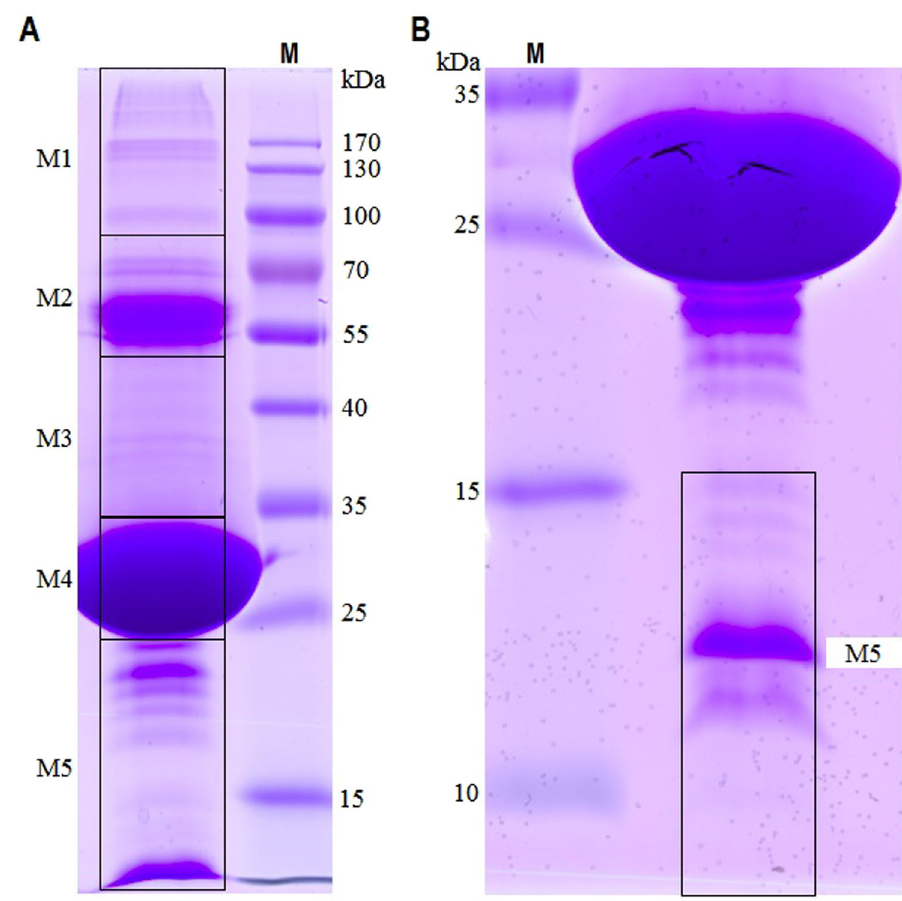
Figure 1. BmNPV polyhedra matrix proteins were separated on 12% ( A ) and 15% ( B ) SDS-PAGE gels. Purified polyhedra were treated with an alkaline solution. Undissolved polyhedra were removed by low-speed centrifugation at 500 × g. The resulting supernatant was collected and then centrifuged by continuous sucrose gradients to remove the ODVs. Protein sample over the upper gradient was separated by SDS-PAGE. Proteins on the gel were excised into five contiguous sections (M1 to M5) and subjected to in-gel digestion and LC- ESI-MS/MS analysis. Two M5 sections shown in ( A ) and ( B ) were combined for the determination. Lane M, protein